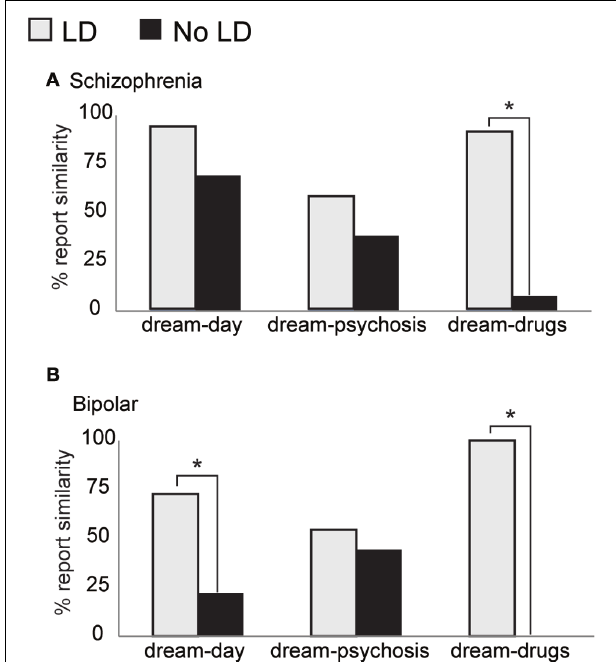
FIGURE 2 | Characteristics of regular dream reports among psychotic patients. (A) Within the S group, there were no significant differences between lucid dreamers and non-lucid dreamers concerning similarities between dream and daily experiences, but lucid dreamers reported changes on dream contents after changes on medication more frequently than non-lucid dreamers ( p < 0.00005). (B) In the B group, lucid dreamers reported similarities between dream and daily experiences, as well as changes on dreams after medication changes, more frequently than non-lucid dreamers ( p = 0.0246 and p < 0.00005, respectively). Neither S nor B showed differences between lucid and non-lucid dreamers on reports about similarities between dreams and psychotic symptoms ( ∗ p <